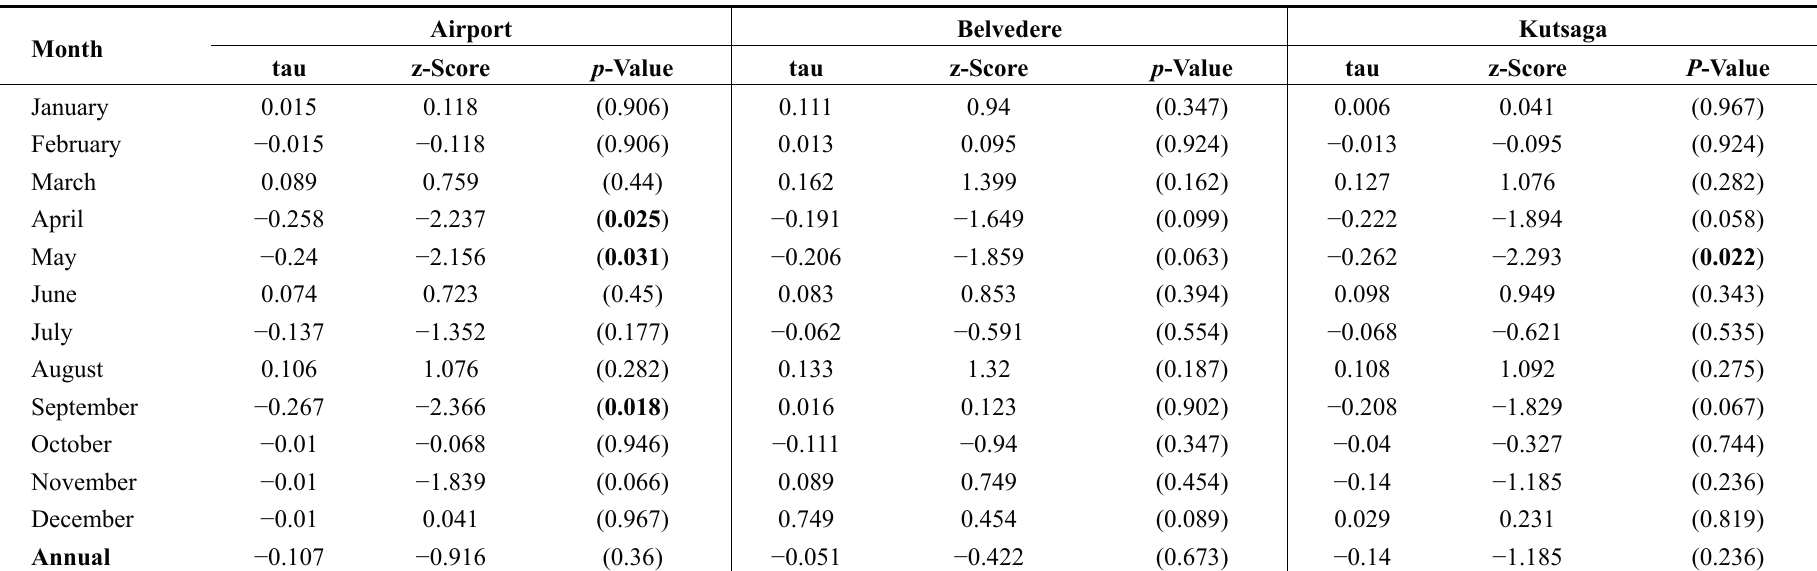
Table 6. The Kendall test statistic (tau) for trend analysis at annual and monthly base for rainfall. Statistically significant trends ( p < 0.05) are shown in